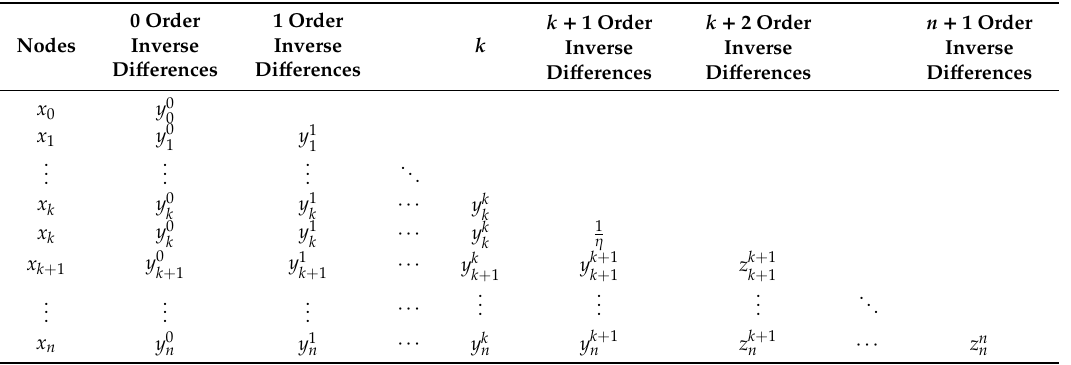
Table 1. Inverse di ff erences table where an inverse di ff erence does not